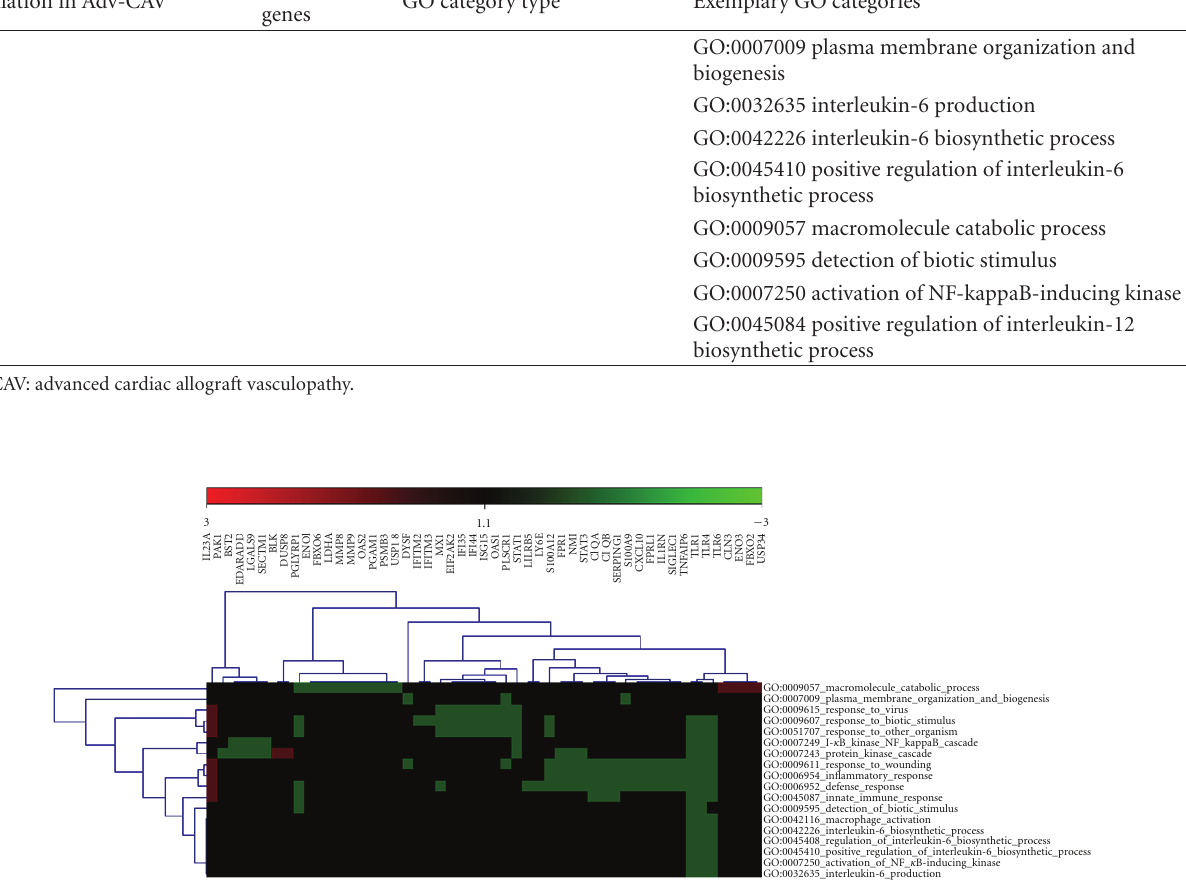
Figure 2: Clustered heat map of enriched GO categories by di ff erentially expressed genes. Instances of cross-talk are shown that links GO categories enriched by similar genes. The green areas show GO categories enriched by the down-regulated genes while small red areas in the corners show GO categories enriched by up-regulated genes.